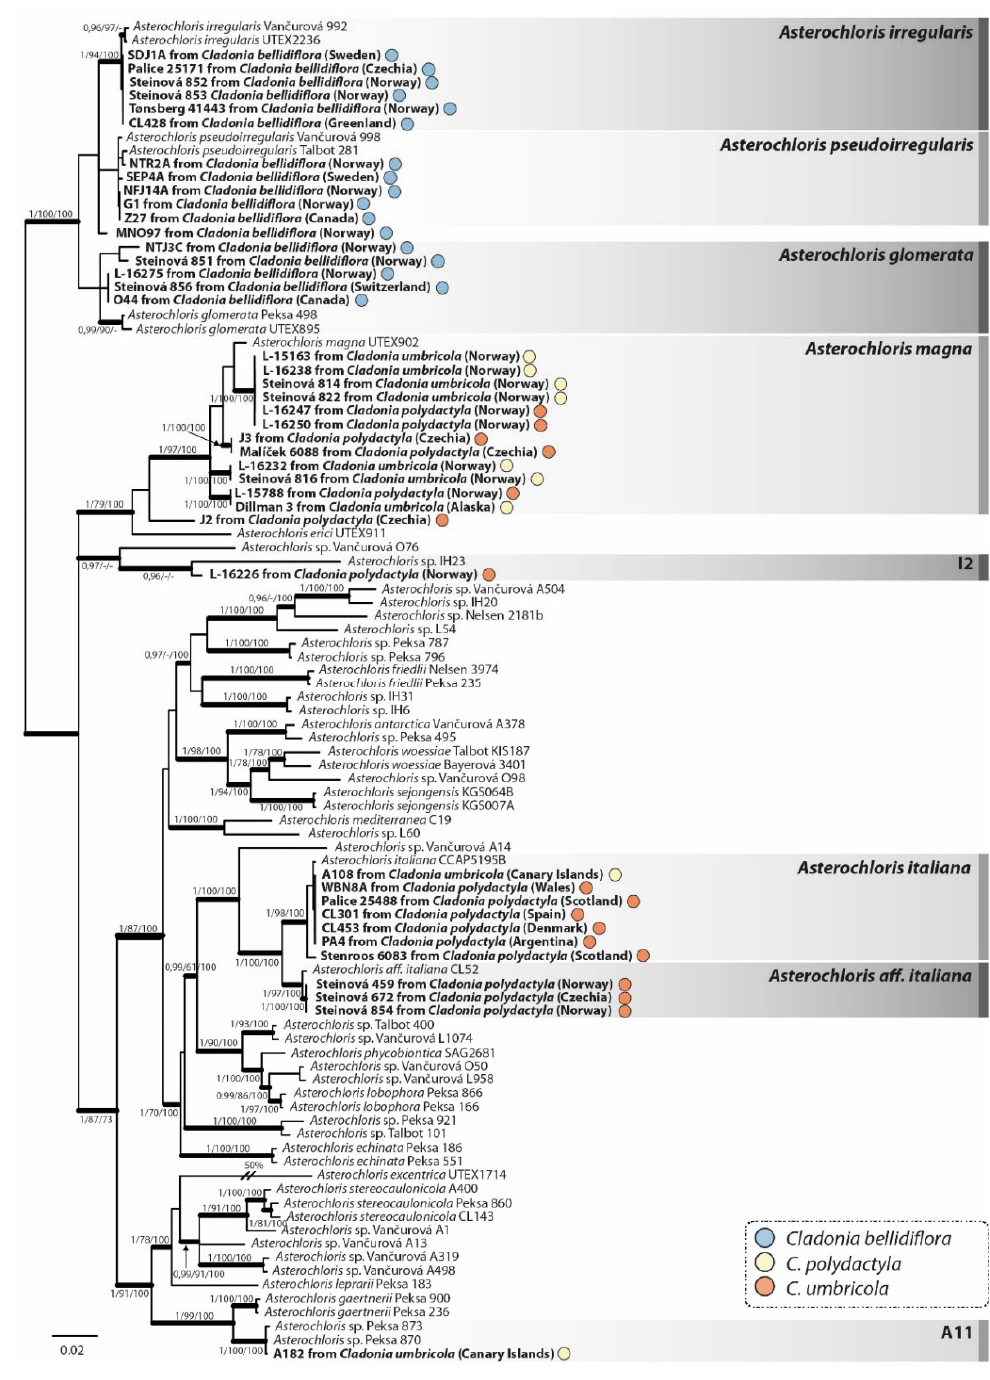
Figure 5. Phylogenetic Bayesian inference of Asterochloris photobionts, based on the combined dataset of ITS rDNA and actin I loci. Bayesian posterior probability values (left) and bootstrap support for the ML (middle) and MP (right) analyses are reported at the corresponding branches (only values >0.95 shown for PP, and >70 for bootstrap). The colour of the dots indicates the mycobiont species from which the photobiont originated, i.e., blue = Cladonia bellidiflora , orange = C. polydactyla and yellow = C. umbricola . Asterochloris lineages associated with any of the Cladonia species studied are in bold. The scale bar shows the estimated number of substitutions per site.